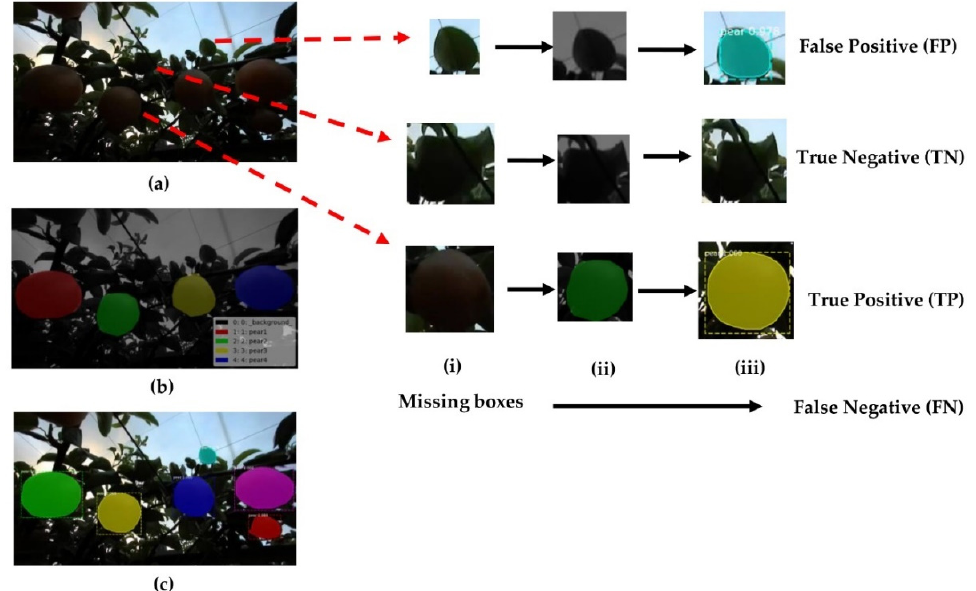
Figure 10. Pear prediction for determining FP, TN, TP, and FN using Mask R-CNN, ( a ) original image; ( b ) cv_mask input image before testing and ( c ) mask image after testing.